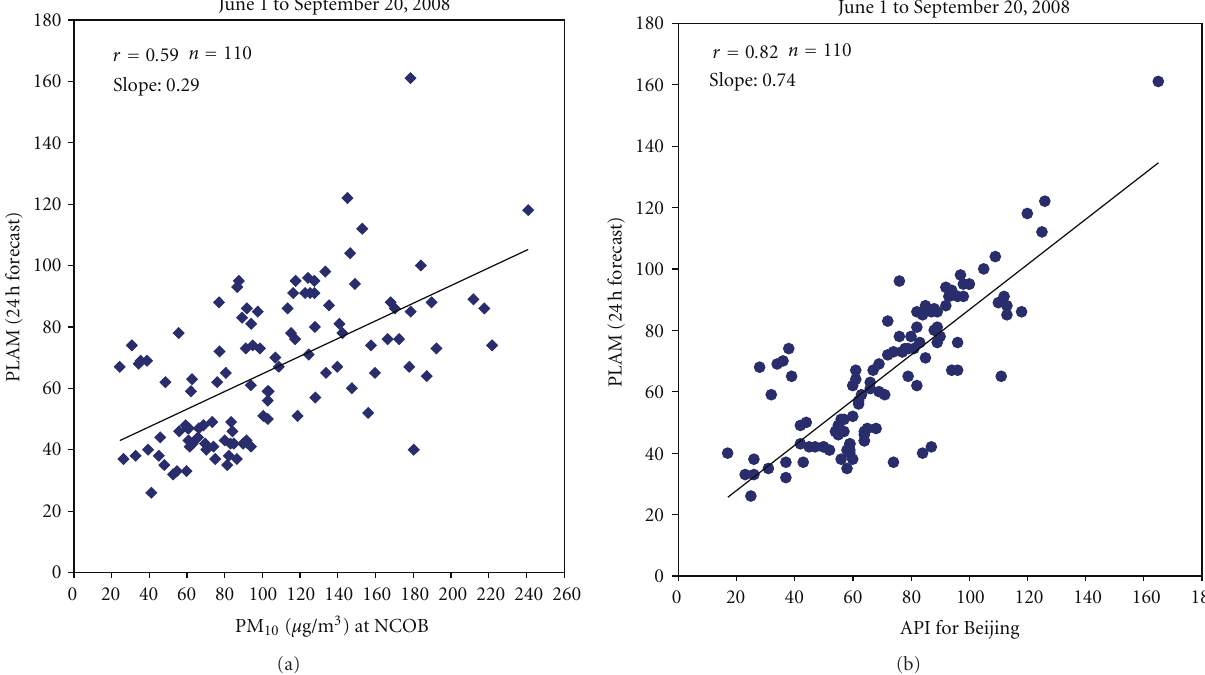
Figure 7: Correlations of 24h PLAM forecast results with actual PM 10 in Beijing Nanjiao (a) and API of Beijing (b) during the period of Beijing Olympic Game.